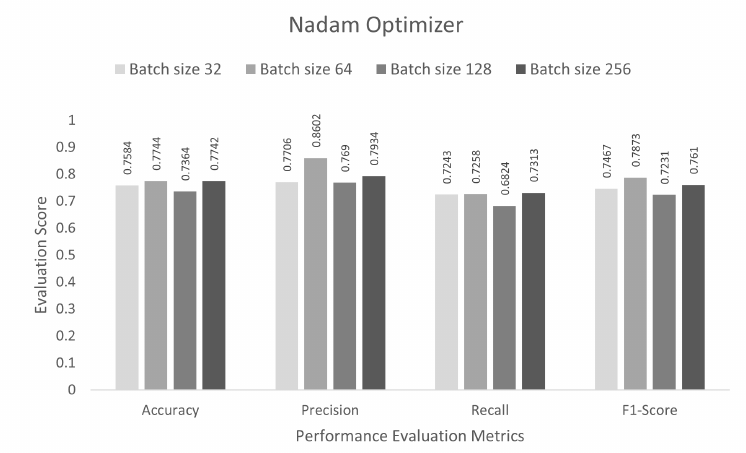
Figure 10. Nadam optimizer for multi-class sub-category classification